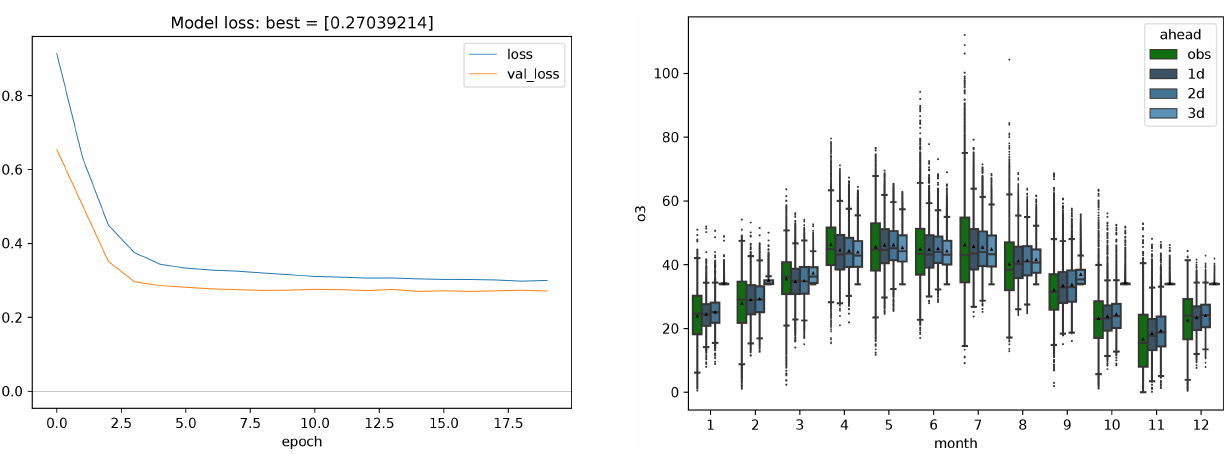
Figure 8. Monitoring plots showing the evolution of train and vali- dation loss as a function of the number of epochs. This plot type is kept very simplistic by choice. The underlying data are saved during the experiment so that it would be easy to create a more advanced plot using the same data.